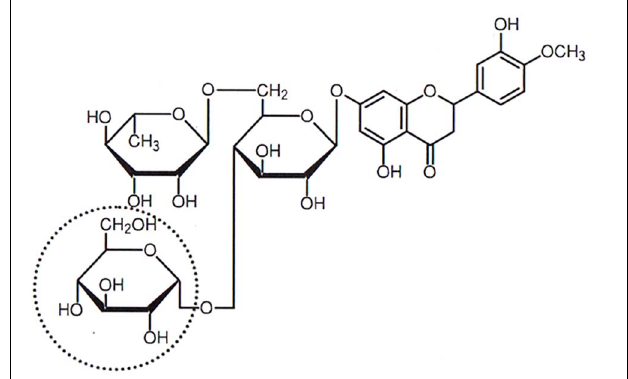
FIGURE 1 | Structure of 4 G - α -D-glucosylhesperidin.